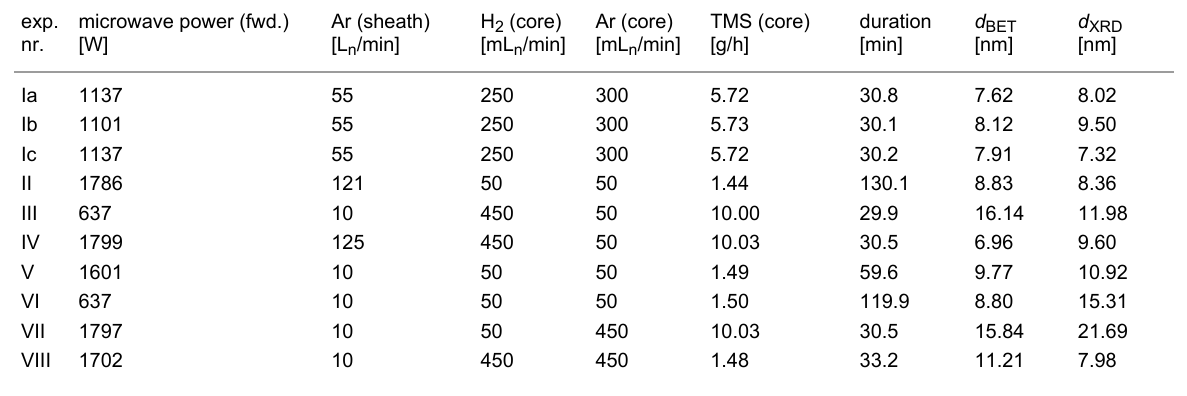
measurements to verify the data. Infrared spectroscopy